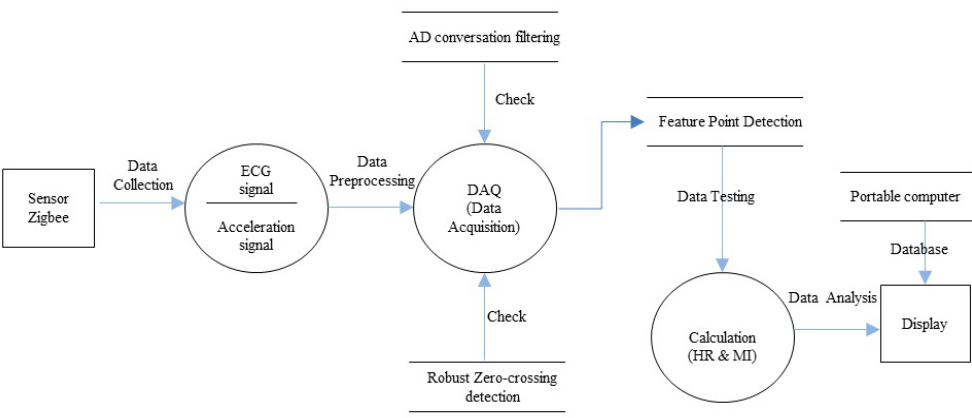
Figure 2. Data flow diagram of wireless sensor system.